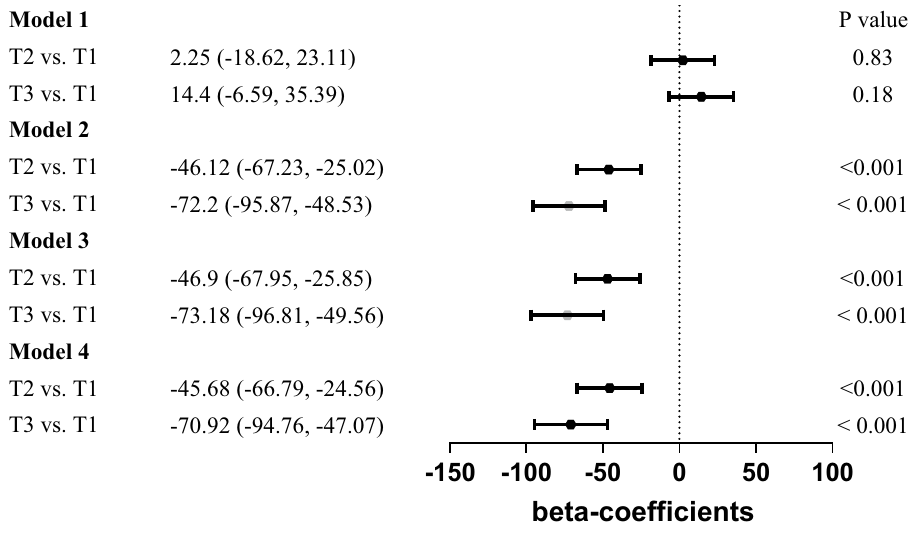
Figure 1. β-coefficient (95% CI) for RBC folate concentration by tertile of serum lead concentration.